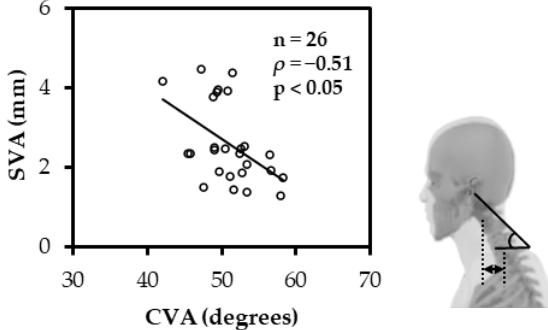
Figure 3. Spearman rank correlation between CVA and SVA. The CVA and SVA had a significant negative correlation. (CVA: cranial vertical angle; SVA: C2-7 sagittal vertical axis).